Question: In a single sentence, describe what this figure presents.
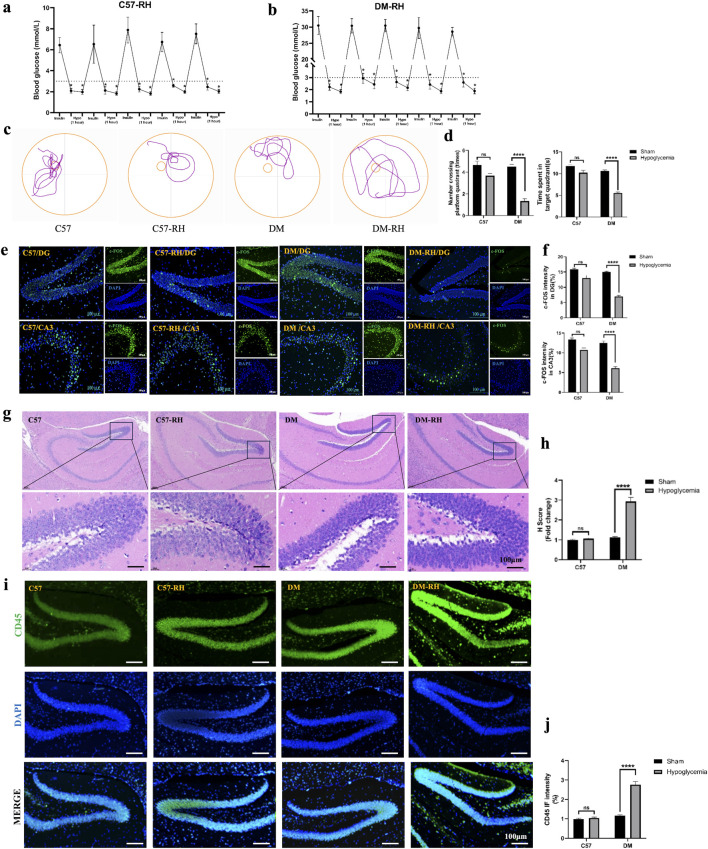
Answer: Recurrent hypoglycemia aggravates cognitive degeneration in type2 diabetic mice. (a,b) Blood glucose record of the C57-RH group (n = 6) and the DM-RH group (n = 6). (c) Representative images of Morris water maze traces of mice in the C57, C57-RH, DM, DM-RH groups. (d) Statistical analysis of number crossing the platform quadrant and the time spent in target quadrant in the Morris water maze experiment (n = 6). (e,f) Immunofluorescent staining and statistical analysis of c-FOS (a marker of neuronal activity) of mouse hippocampus in different groups (n = 6). (g,h) H&E staining and histological score (H score) of mouse hippocampus in different groups. (i,j) Immunofluorescent staining and statistical analysis of CD45 of mouse hippocampus in different groups (n = 6). ns, no significance; **** p <0.0001 vs. the DM group.